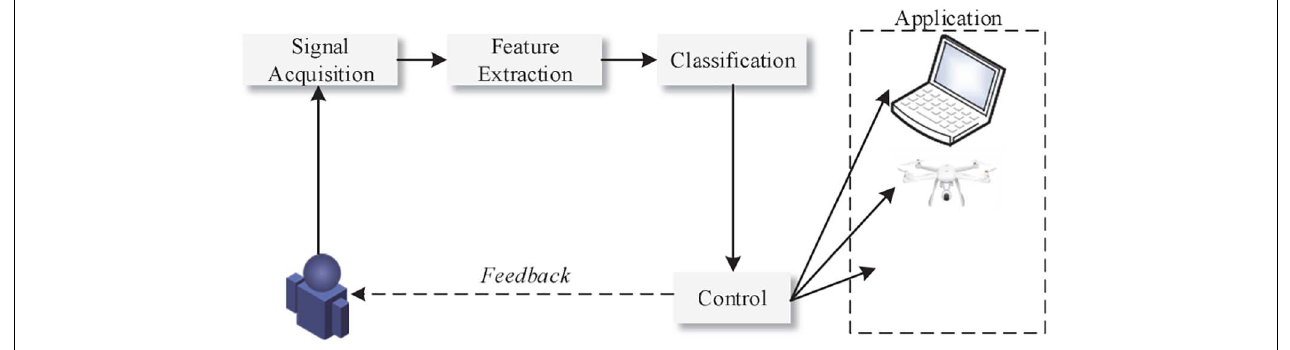
FIGURE 1 | Structure of motor imagery recognition